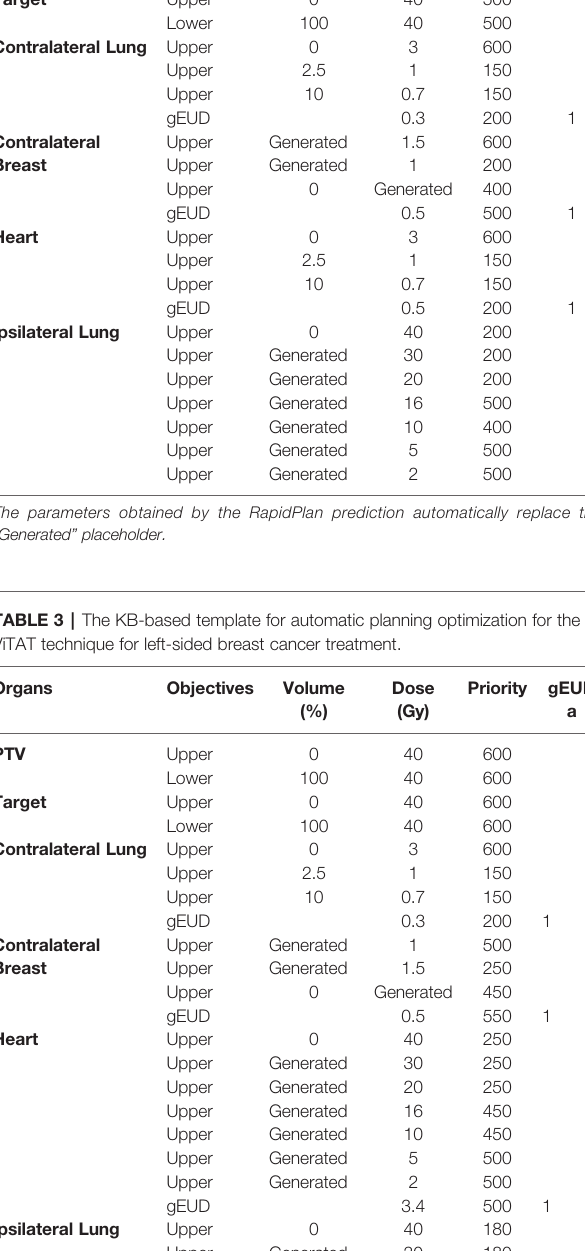
TABLE 2 | The KB-based template for automatic planning optimization for the ViTAT technique for right-sided breast cancer treatment. Organs